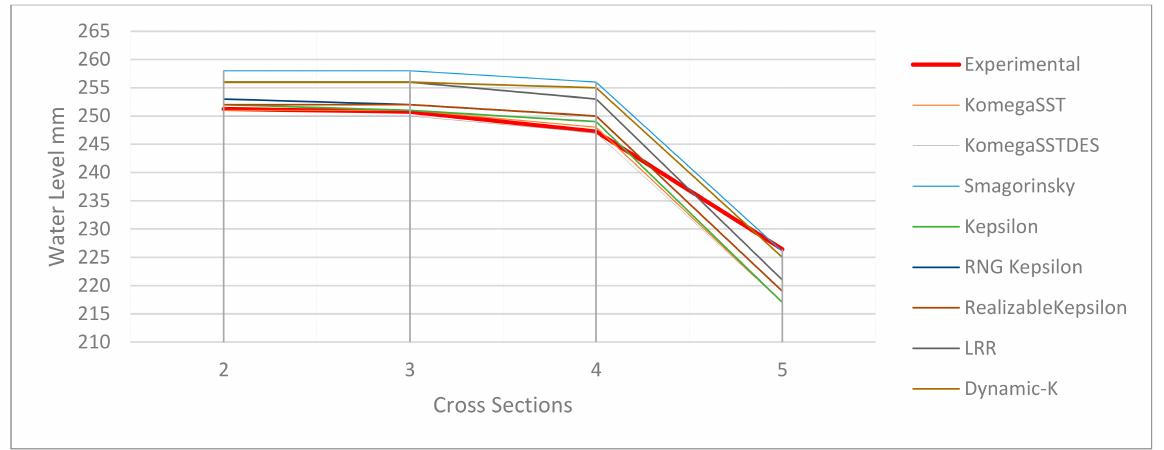
Figure 5. Comparison of experimental water level results (obtained with the average measuring error of 1.93–2.58%) with the numerical simulation results for the discharge of 10 L/s (for cross-sections 2–5).